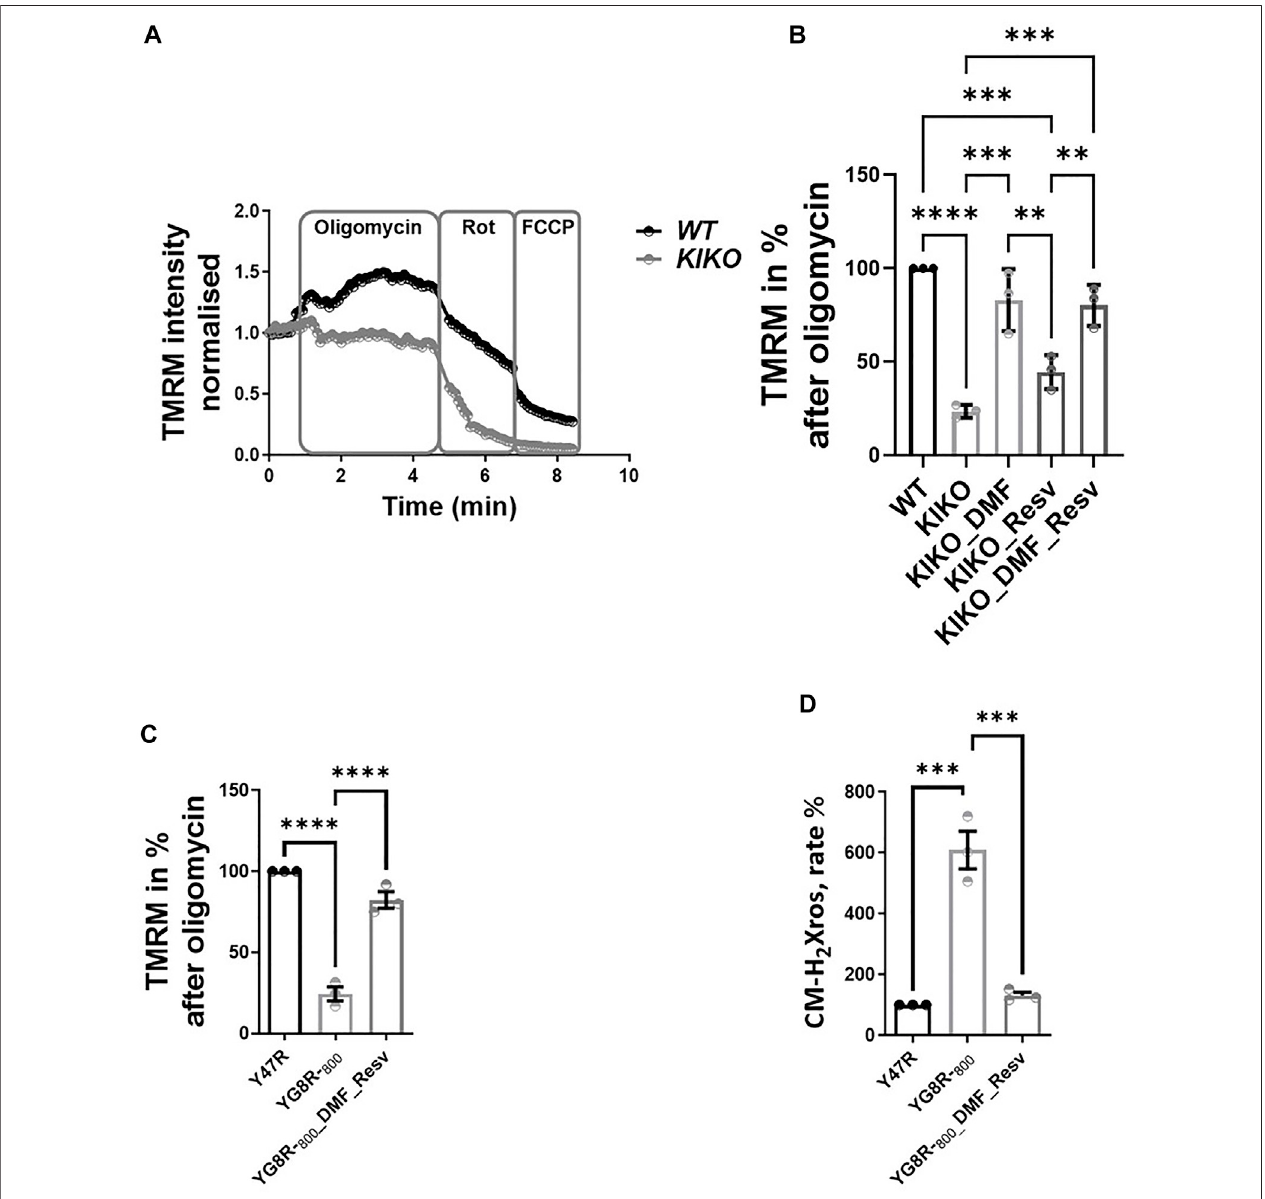
FIGURE 2 | Ef fi cacy of DMF and DMF and Resv to prevent depolarization in KIKO CGNs. Forty-eight hours prior to experiments, the different compounds were administered at the following concentrations: 30 µM DMF and 100 µM Resv. (A) Kinetic curves of the TMRM fl uorescence assessing the ΔΨ m challenged by 2 μ g/ml oligomycin, 1 µM rotenone, and 1 µM FCCP. (B) Difference in ΔΨ m response to oligomycin normalized to WT taken as 100% (KIKO 23.7 ± 3.5; KIKO_DMF 83 ± 16; KIKO_Resv 44.7 ± 9; KIKO_DMF_Resv 80.3 ± 10.9; **** p < 0.0001; *** p < 0.0005; ** p < 0.005; * p < 0.05; n > 3 independent experiments). (C) Difference in ΔΨ m responsetooligomycinnormalizedto (control) taken as100%(YG8R- 800 24.3 ± 7.4; YG8R- 800 _DMF – Resv 82.4 ±8.6). (D) Rate ofmROS normalizedto Y47R (control) (mean ± SD; YG8R- 800 609 ± 107; YG8R- 800 _DMF – Resv 131 ± 19; one-way ANOVA with Tukey ’ s multiple comparisons test). *** p < 0.0005; n > 3 independent